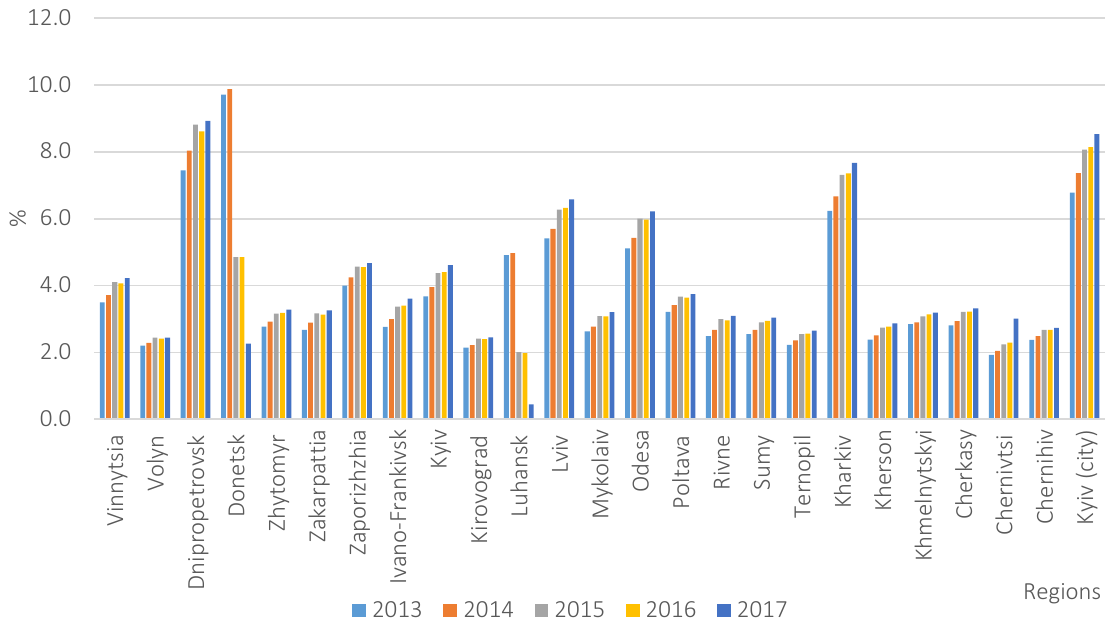
Figure 4. Dynamics of the change in the share of the economically active population by regions for